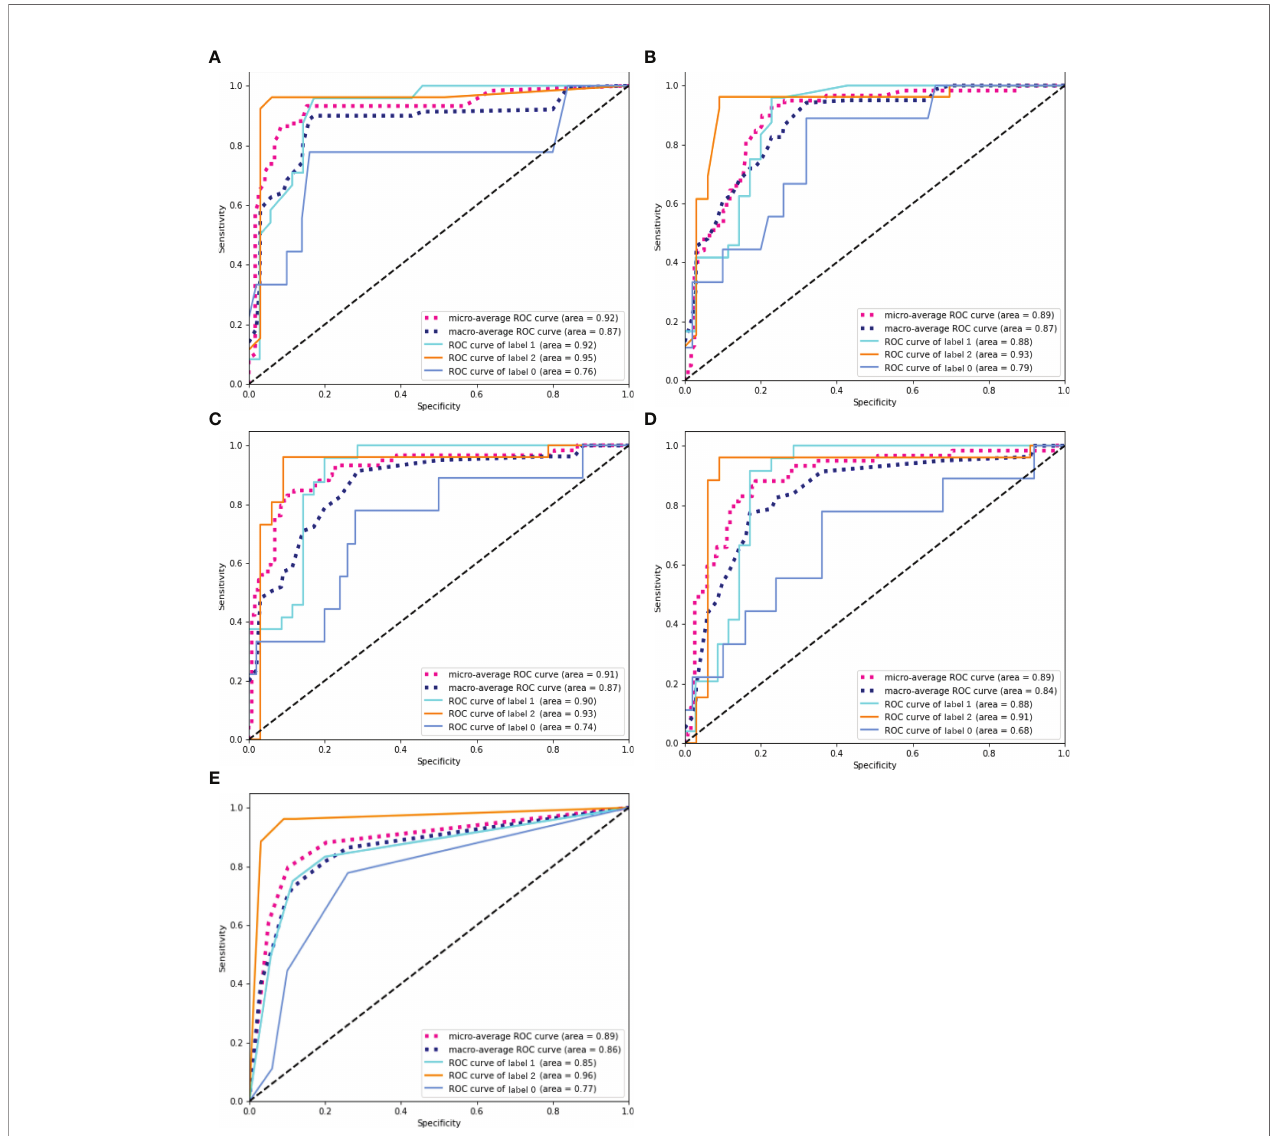
FIGURE 4 | ROC curves of fi ve ML prediction models. (A) ROC curve of RF. (B) ROC curve of AdaBoost. (C) ROC curve of GBDT. (D) ROC curve of LR. (E) ROC curve of KNN. The solid line represents the prediction ef fi ciency of each group in the corresponding model. Dotted lines represent the overall prediction performance of the models, including the macro-average ROC curves and micro-average ROC